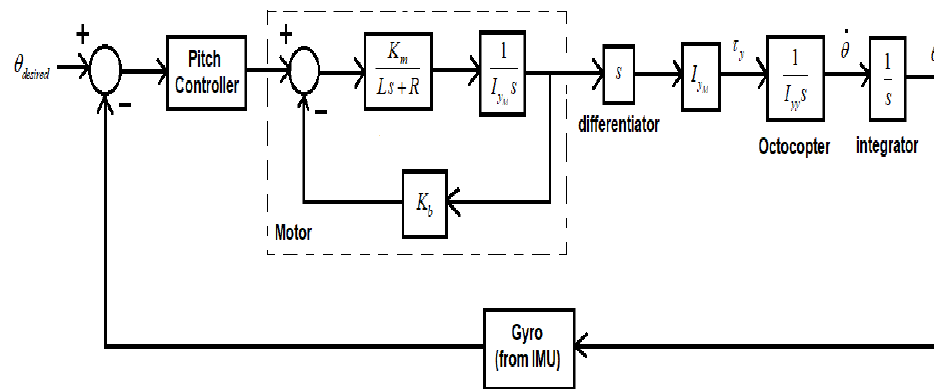
Figure 10. Pitch attitude control loop.